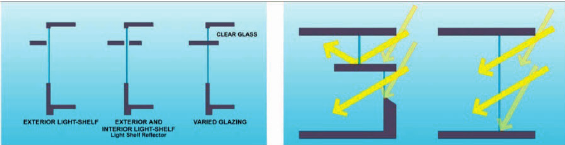
Fig. 6. The various forms of light shelf